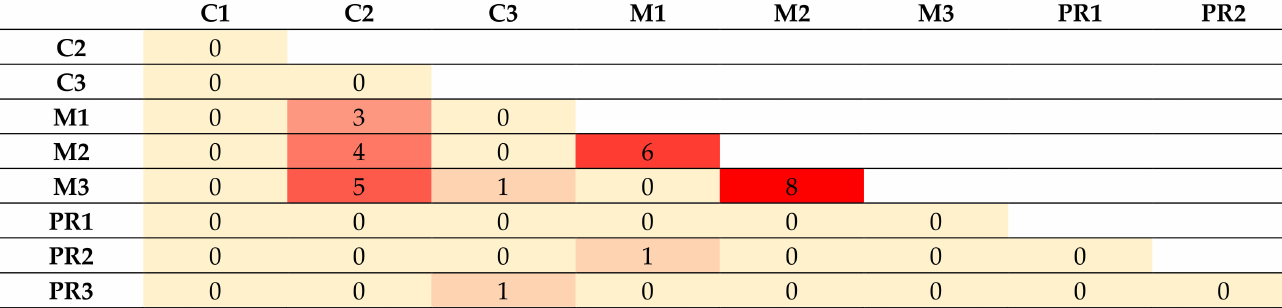
Figure 4. Interactions between two codes within the Danish